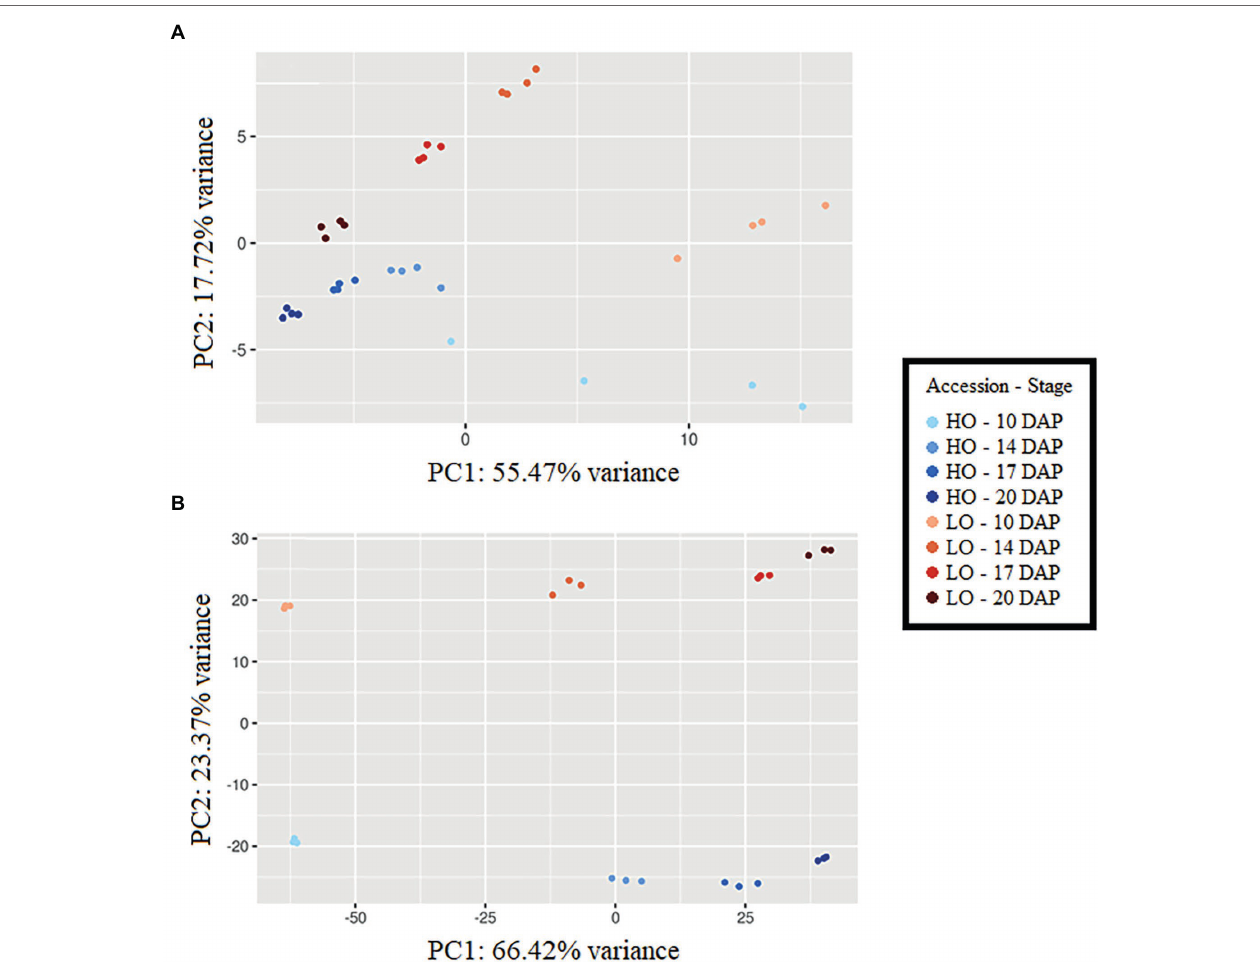
FIGURE 2 | Principle component analysis using metabolomic dataset (A) and transcriptomic dataset (B) , DAP, days after pollination; HO, High oil accession; LO, Low oil accession. Principal component analysis was carried out on log-transformed and auto-scaled metabolite concentrations expressed in pmol mg dry weight (DW) − 1 using PCAGO (Gerst and Hölzer,